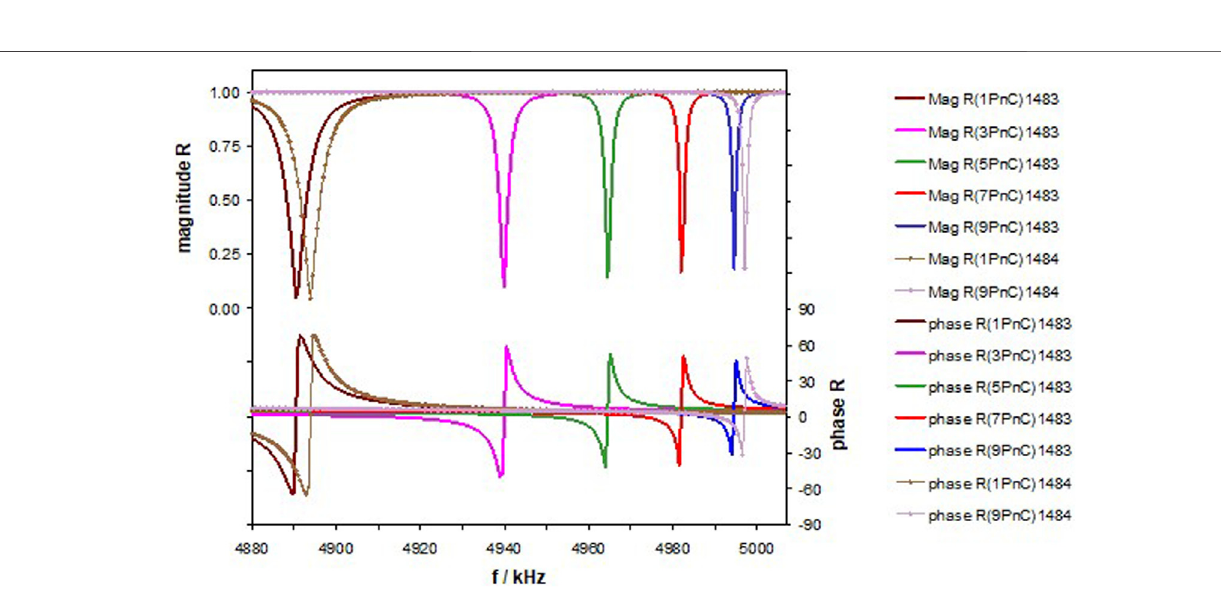
Frontiers in Mechanical Engineering |